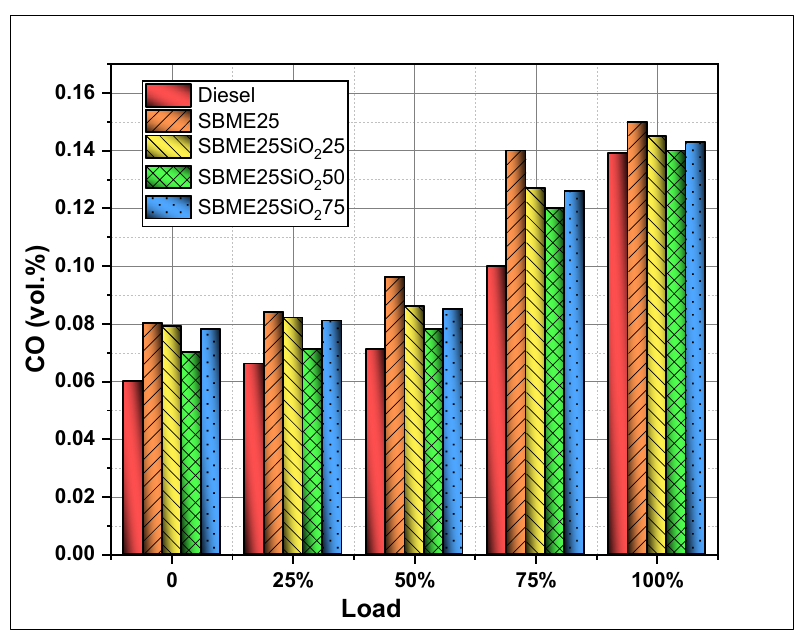
Figure 10. Effect of SiO 2 nano-additives on CO emission at varying loads.